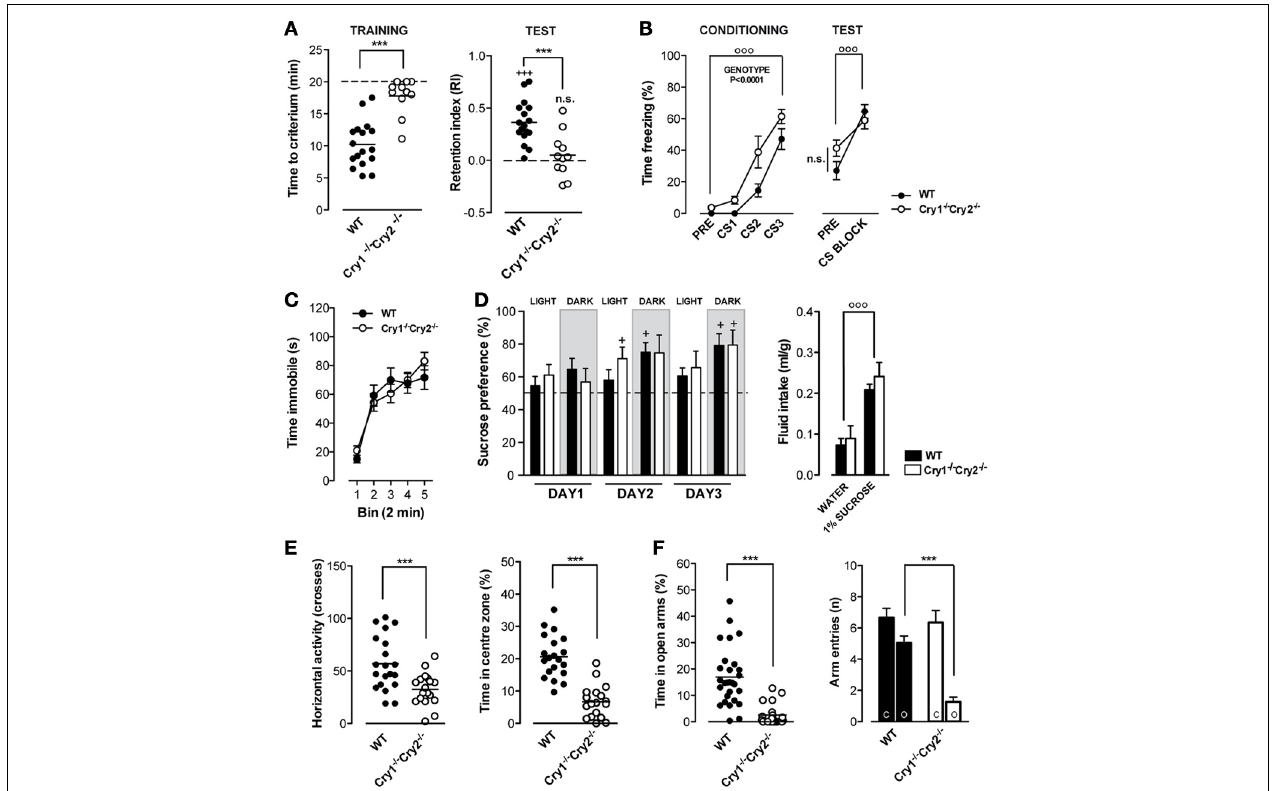
FIGURE 2 | Cognitive processing, depression-related behavior, and anxiety-related behavior in Cry1 − / − Cry2 − / − mice. (A) During the training phase of the object recognition test (left panel), Cry1 − / − Cry2 − / − mice ( n = 11) required more time [ t ( 26 ) = 5 . 971, P < 0 . 0001] to reach the criterion of 40s total object exploration compared to wild type (WT) mice ( n = 17). During the test phase, 24h later, Cry1 − / − Cry2 − / − mice did not show a preference for the novel object as opposed [ t ( 26 ) = 3 . 895, P = 0.0006] to WT mice, which had a retention index above 0 [ t ( 16 ) = 7 . 389, P < 0 . 0001]. (B) In the auditory fear conditioning test, Cry1 − / − Cry2 − / − mice ( n = 8) readily associate the tone with the ensuing foot shock, but display higher [Genotype × Time: F ( 3 , 45 ) = 2 . 52, P = 0.07; Genotype: F ( 1 , 45 ) = 10 . 81, P = 0.005; Time: F ( 3 , 45 ) = 58 . 98, P < 0 . 0001] freezing levels compared to WT mice ( n = 10). During the test, 24h later, both genotypes showed an elevated freezing response